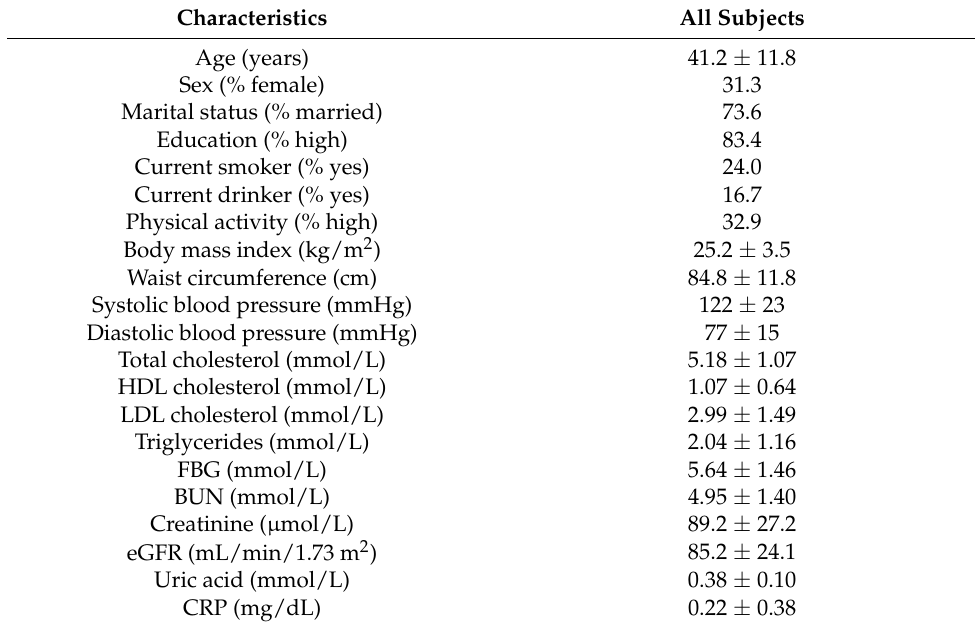
Table 1. Characteristics of all the subjects ( n = 56,476) 1 .